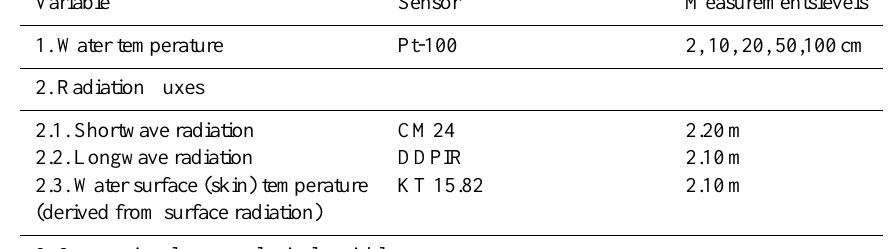
Table 2. Meteorological variables measured at Kossenblatter See in 2003, 1 May–10 November, by Lindenberg Meteorological Observatory. Variable